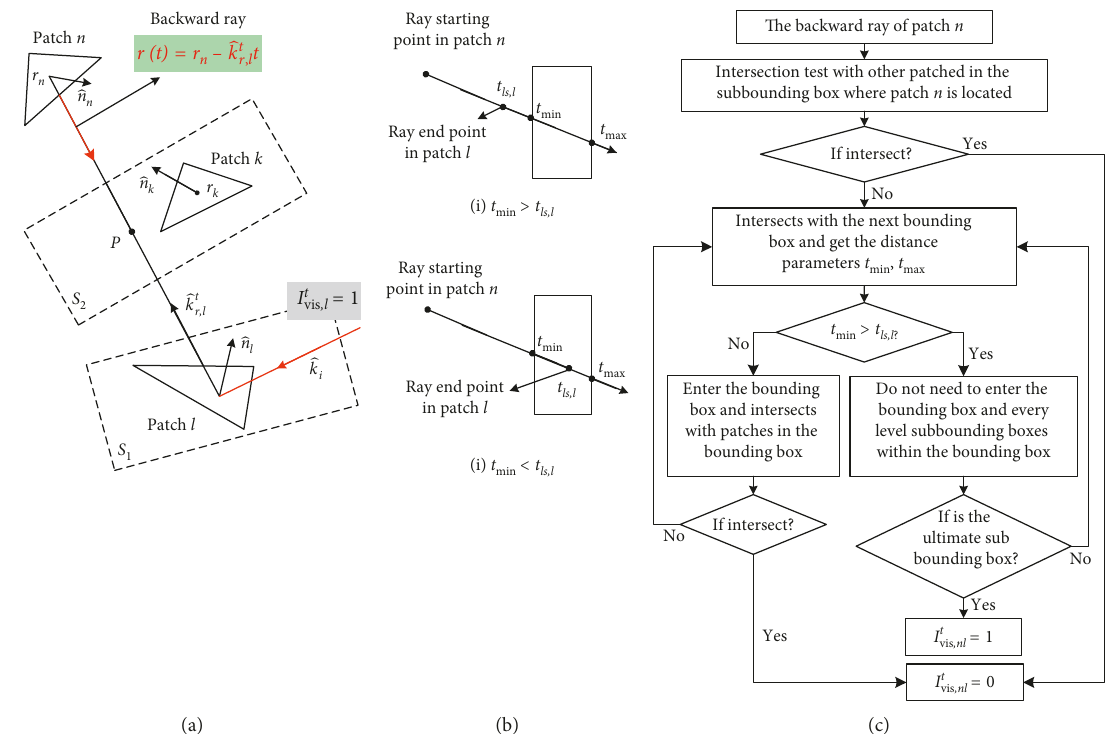
Figure 5: Visibility test of I t . (a) The relationship of shade between the patches. (b) The relationship of the ray and bounding box: vis ,nl (i) t > t ls,l and (ii) t < t ls,l . (c) The traversal of the reflected ray with patches. min min